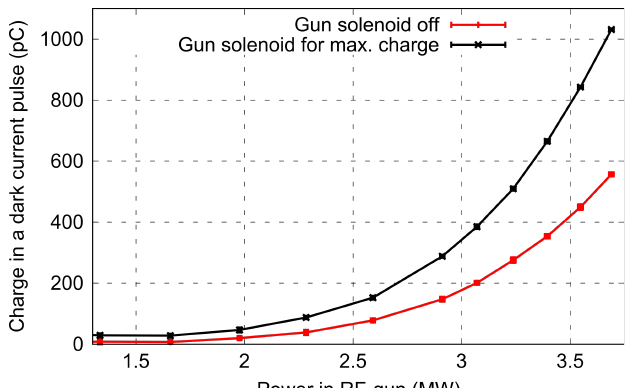
Figure 12. Dark charge measurement during an RF power scan. The data were taken with and without solenoid focusing to the Faraday